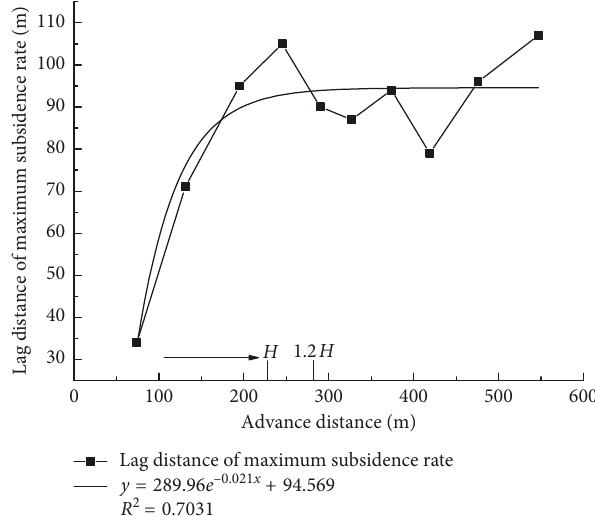
Figure 7: Dynamic curve of maximum subsidence